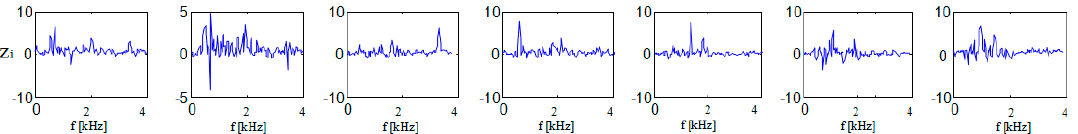
Figure 2. Spectrograms of constituent signals, ( a ) S1—ringer; ( b ) S2—baby and ( c ) the mixed signal S1 + S2.